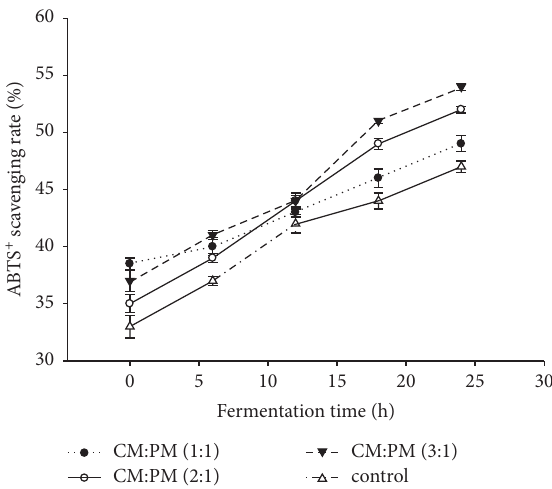
Figure 6: ABTS+free radical scavenging rate of four samples at different fermentation times. All the values are expressed as mean ± SD ( n � 3). CM, cowpea milk; PM, peanut milk. Table 2: Amino acid content of fermented cowpea-peanut milk with L. rhamnosus Yoba. Fermented milk samples Amino acid (g/100g) CM :PM (1:1)